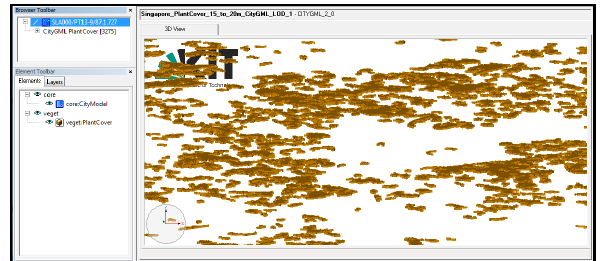
Figure 12. LOD 1 Vegetation represented as PlantCover